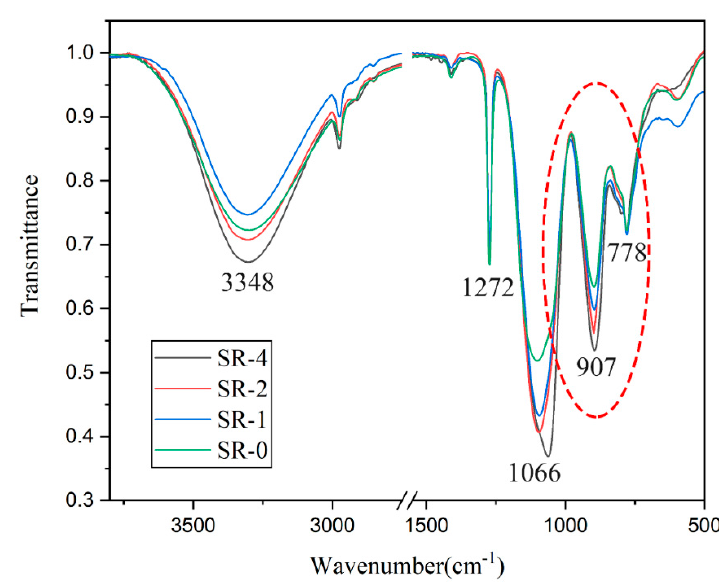
Figure 4. FTIR spectra of the silicon resins.